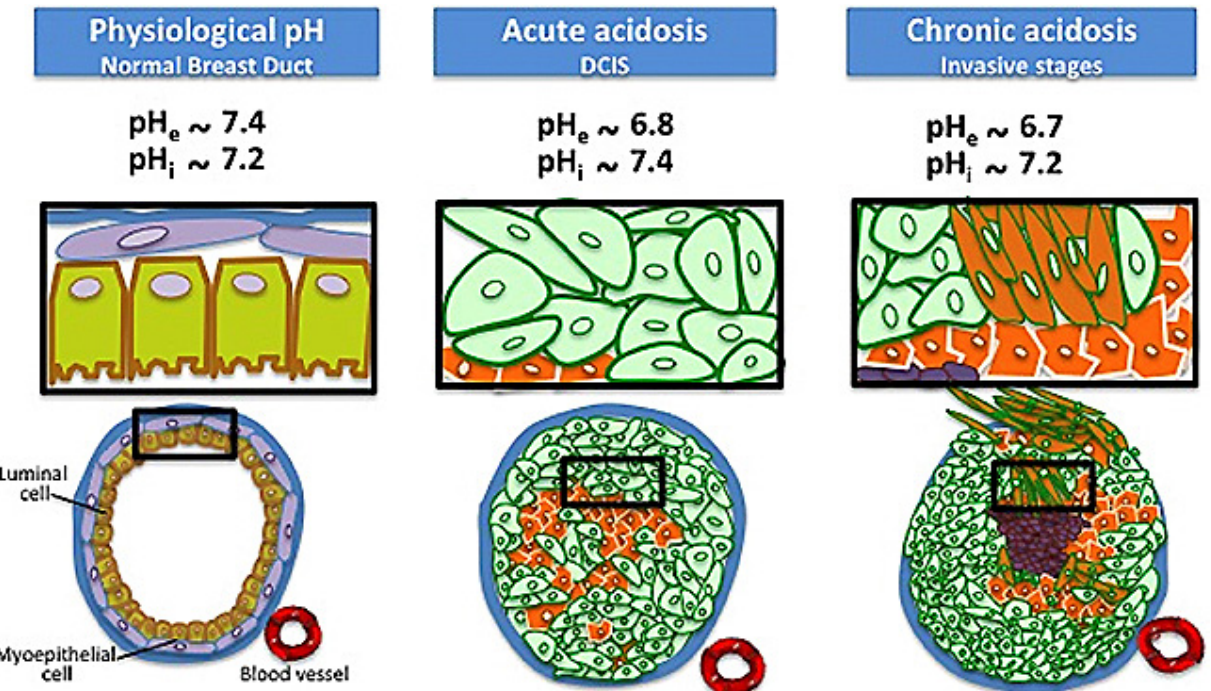
Figure 5. Schematic of reversal changes in extracellular and intracellular pH values of cancer cells compared with normal cells. Reprinted with permission from ref. [66]. Copyright 2013 Damaghi, Wojtkowiak and Gillies.